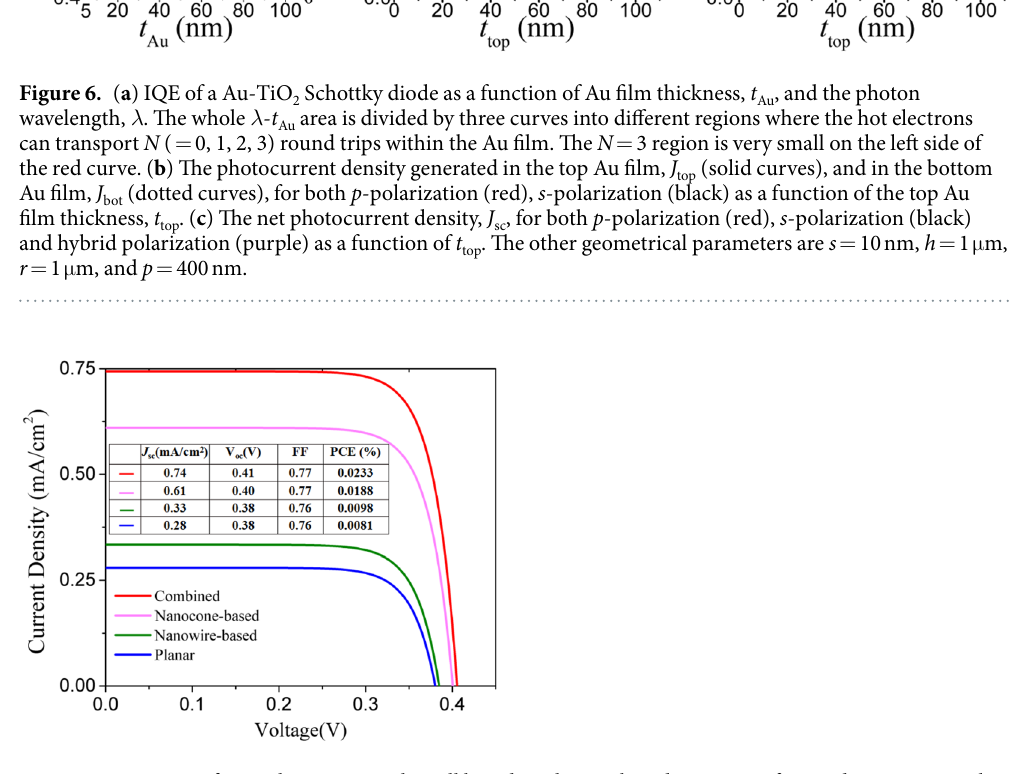
Figure 7. J - V curves for our hot-carrier solar cell based on the combined structure of capped nanowires with top nanocones (red), the solar cells based on the nanocones only (pink) and the nanowires only (green), and the planar cell (blue). The inset table summarizes the characteristic parameters, i.e., J sc , V oc , FF, of the four cells. The geometrical parameters are s = 10 nm, h = 1 μ m, r = 1 μ m, p = 400 nm, and t top = 70